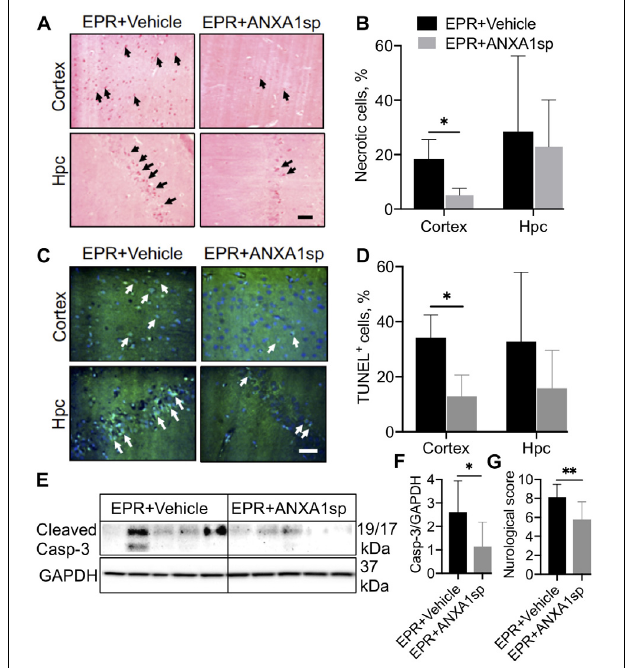
FIGURE 4 | Necrosis and apoptosis in the CNS after exsanguination cardiac arrest/EPR and ANXA1sp or vehicle treatment. (A,B) Necrosis, detected by acid fuchsin-celestine blue, was reduced in the cerebral cortex of ANXA1sp treated rats. Arrowheads in panel A identify acidophilic neurons in the cortex and hippocampus (Hpc). (C,D) Terminal deoxynucleotidyl nick-end labeling (TUNEL) staining and quantification of apoptotic cells. Apoptosis was significantly reduced in the cerebral cortex of ANXA1sp-treated rats on postoperative day 1. Arrowheads in panel (C) identify pyknotic positive cells. Scale bar: 20 µ m. (E,F) Western blot analysis of cleaved caspase-3 revealed significantly reduced levels in brain homogenates from ANXA1sp-treated animals compared to vehicle (controls). (G) Neurologic score (sensory-motor function) was significantly improved at postoperative day 1 in ANXA1sp rats. Data presented as mean ± SD ( n = 5–7/group), ∗ P < 0.05 and ∗∗ P < 0.01 compared to vehicle (controls) analyzed by unpaired t -test (B,D,F) or Mann–Whitney U -test (G)